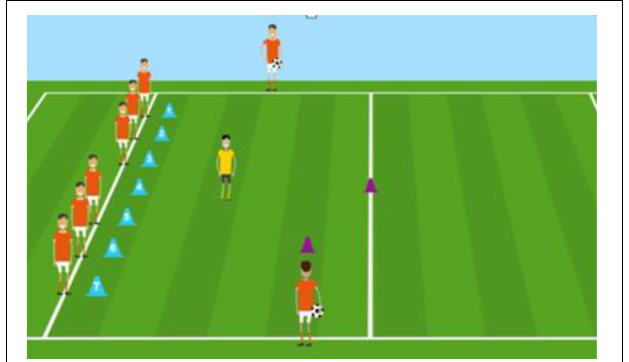
FIGURE 1 | A screenshot from the 3D game animation.